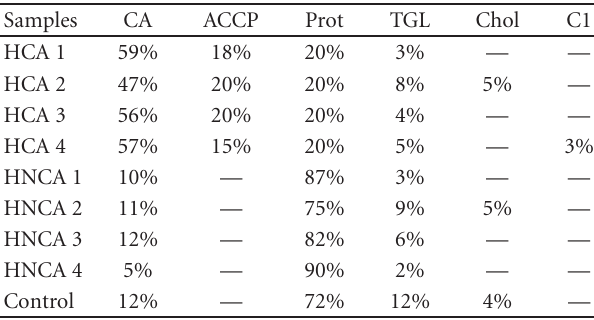
Table 1: Chemical composition of crystalline ultrastructures in inconspicuous valve areas (HNCA) and in massive calcifications of the same samples (HCA) given by FT-IR: proportions of proteines (Prot) and tendencially triclycerides (TGLs) are higher in areas with crystalline ultrastructures. Carbonated calcium hydroxylap- atite (CA) is present in inconspicuous areas, while amorphous carbonated calcium phosphate (ACCP) is only present in massive calcifications. No significant di ff erences were found for cholesterol (Chol) or whewellite